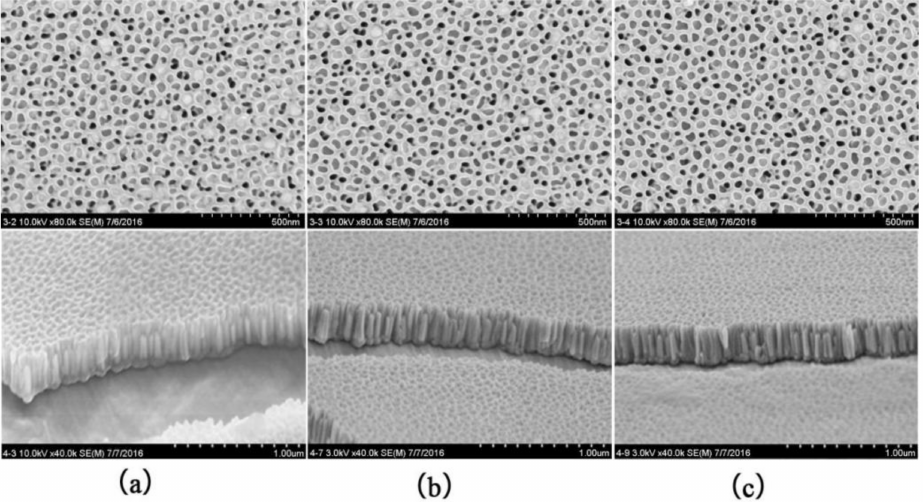
Figure 6. SEM surface and cross-sectional images of alumina-Co composite film. Parts ( a – c ) corre- sponding to positions A to C in Figure